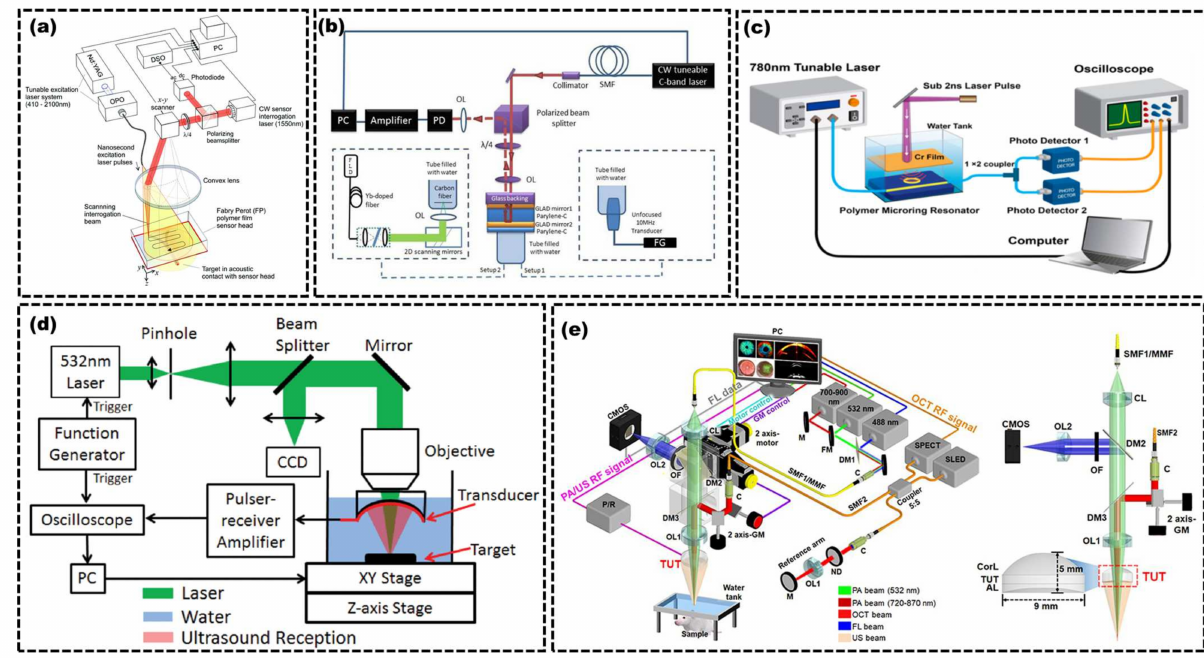
Figure 4. ( a ) Backward-mode multiwavelength PA scanner with a FP US sensor. CW: continuous wave, DSO: digitizing oscilloscope, OPO: optical parametric oscillator. Reprinted with permission from ref. [42]. Copyright 2008 Optical Society of America; ( b ) The experimental setup used for testing a GLAD-FP US sensor. Two separate setups are shown. Setup 1 is used for PAI. Setup 2 is used to test the receive sensitivity using an external ultrasound transducer. PD: photodiode, OL: objective lens, SMF: single mode fiber, FG: function generator, FLD: fiber laser driver. Adapted with permission from ref. [51]. Copyright 2013 Optical Society of America; ( c ) PAI setup with a MRR US sensor. Adapted with permission from ref. [44]. Copyright American Chemical Society; ( d ) Test setup for characterizing the optical and acoustic properties of focused transparent transducer. Reprinted with permission from ref. [26]. Copyright 2020 Institute of Electrical and Electronics Engineers; ( e ) Schematic diagrams of a seamlessly integrated quadruple fusion imaging system using a TUT: USI, OCT, and FLI. Overall schematic (left), magnified schematic of the imaging head module (right). PC: personal computer, RF: radio frequency, M: mirror, FM: flipping mirror, ND: neutral density filter, C: collimator, CorL: correction lens. Reprinted with permission from ref. [32]. Copyright 2021 Proceedings of the National Academy of Sciences of the United States of